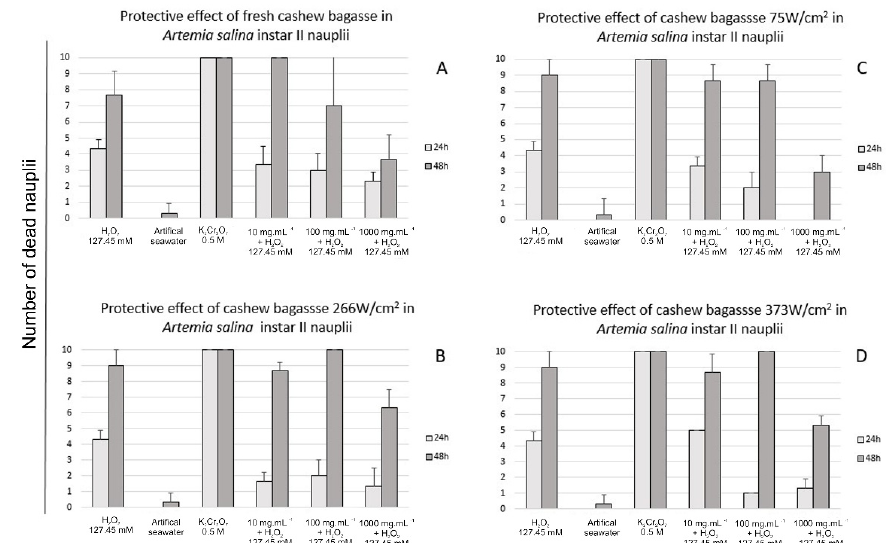
Figure 6. Protective effect of sonicated cashew apple bagasse (10, 100, and 1000 µ g/mL) in Artemia salina instar II nauplii at 24 and 48 h of exposure. No significant protective effect was noted in fresh ( A ), 75 W/cm 2 ( B ), 266 W/cm 2 ( C ), or 373 W/cm 2 ( D ) sonicated cashew bagasse at 24 or 48 h of exposure. Negative control (artificial seawater) did not cause significant death of nauplii. Conversely, positive control (K 2 Cr 2 O 7 0.5 M) was lethal for 100% of individuals, including 24 h of exposure. H 2 O 2 at LC 50 (127.45 mM) cause death of nearly 50% of individuals at 24 h exposure and death of nearly all nauplii at 48 h of exposure.